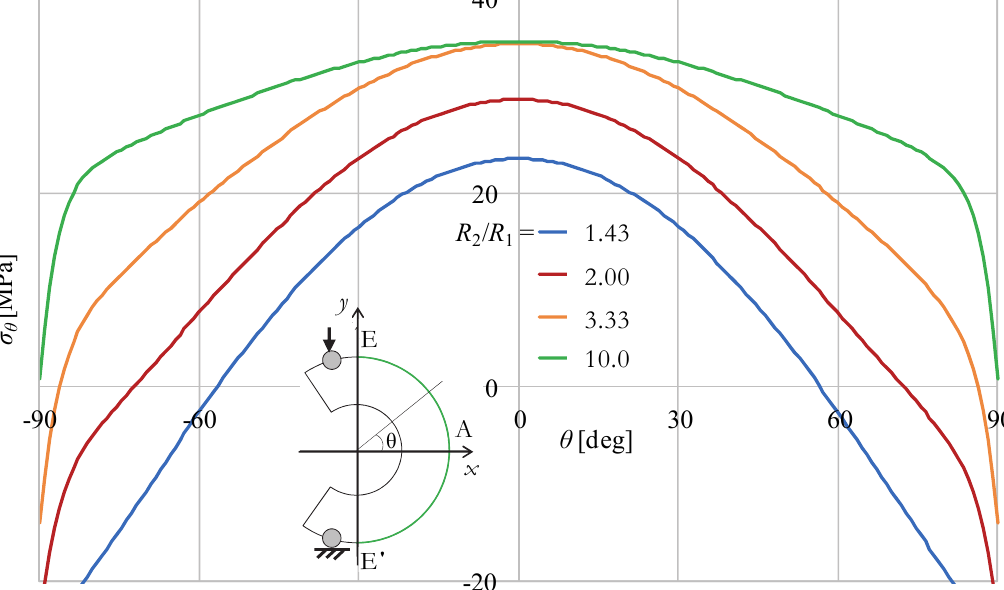
Figure 13: The polar distribution of the transverse normal stress along the outer perimeter of the CSR for various ρ -values.